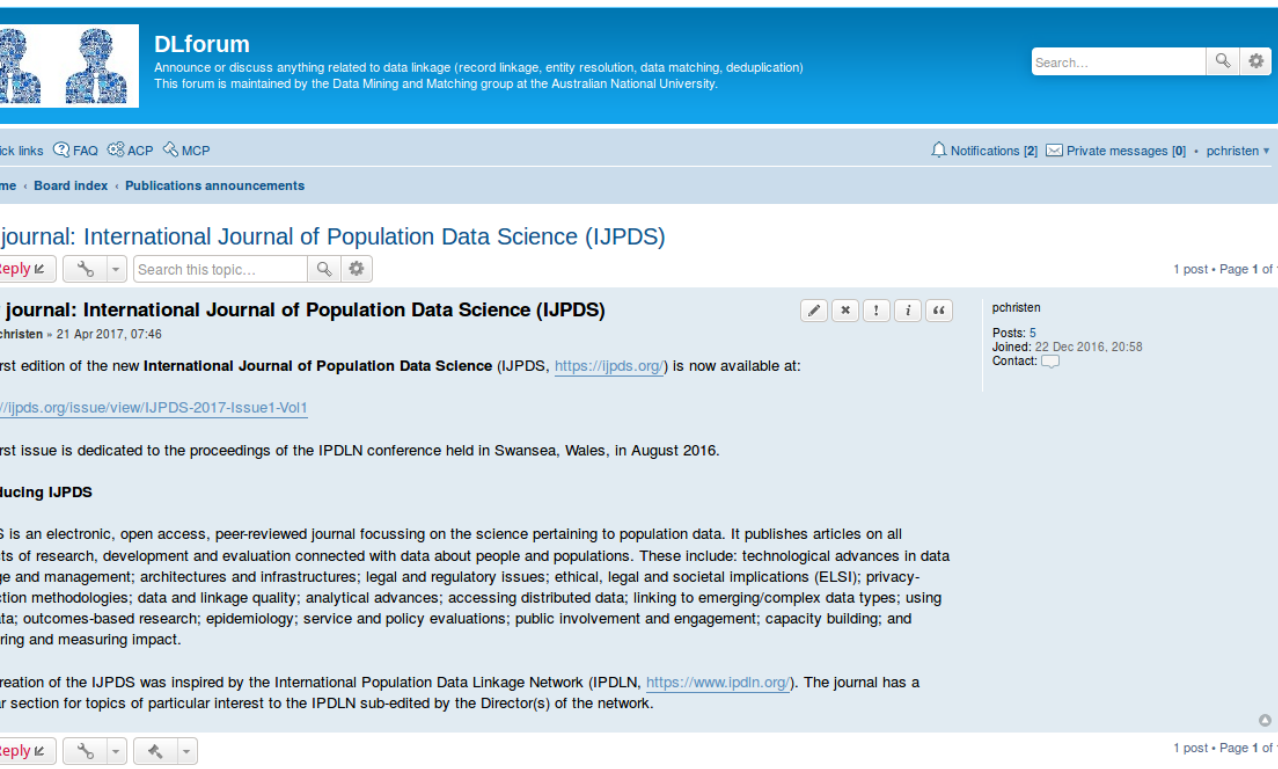
Figure 3: An individual example post announcing the